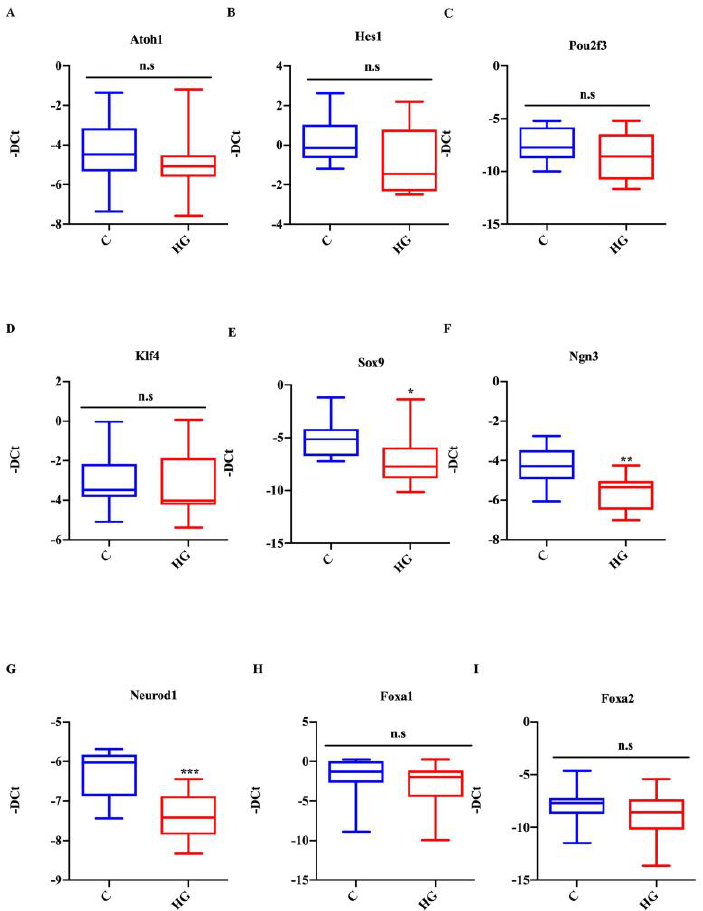
Figure 4. Effect of high glucose treatment on the expression of TFs associated with intestinal cell differentiation. Expression of Atoh1 ( A ), Hes1 ( B ), Pou2f3 ( C ), Klf4 ( D ), Sox9 ( E ), Neurog3 ( F ), Neurod1 ( G ), Foxa1 ( H ), and Foxa2 ( I ) in intestinal organoids cultured with high glucose (35 mM) for 48 h. Data generated from three biological replicates from five mice. Unpaired Student t -test: * p < 0.05, ** p < 0.01, *** p < 0.001; n.s. not significant. C = Control (17.5 mM glucose). HG = High Glucose (35 mM glucose).